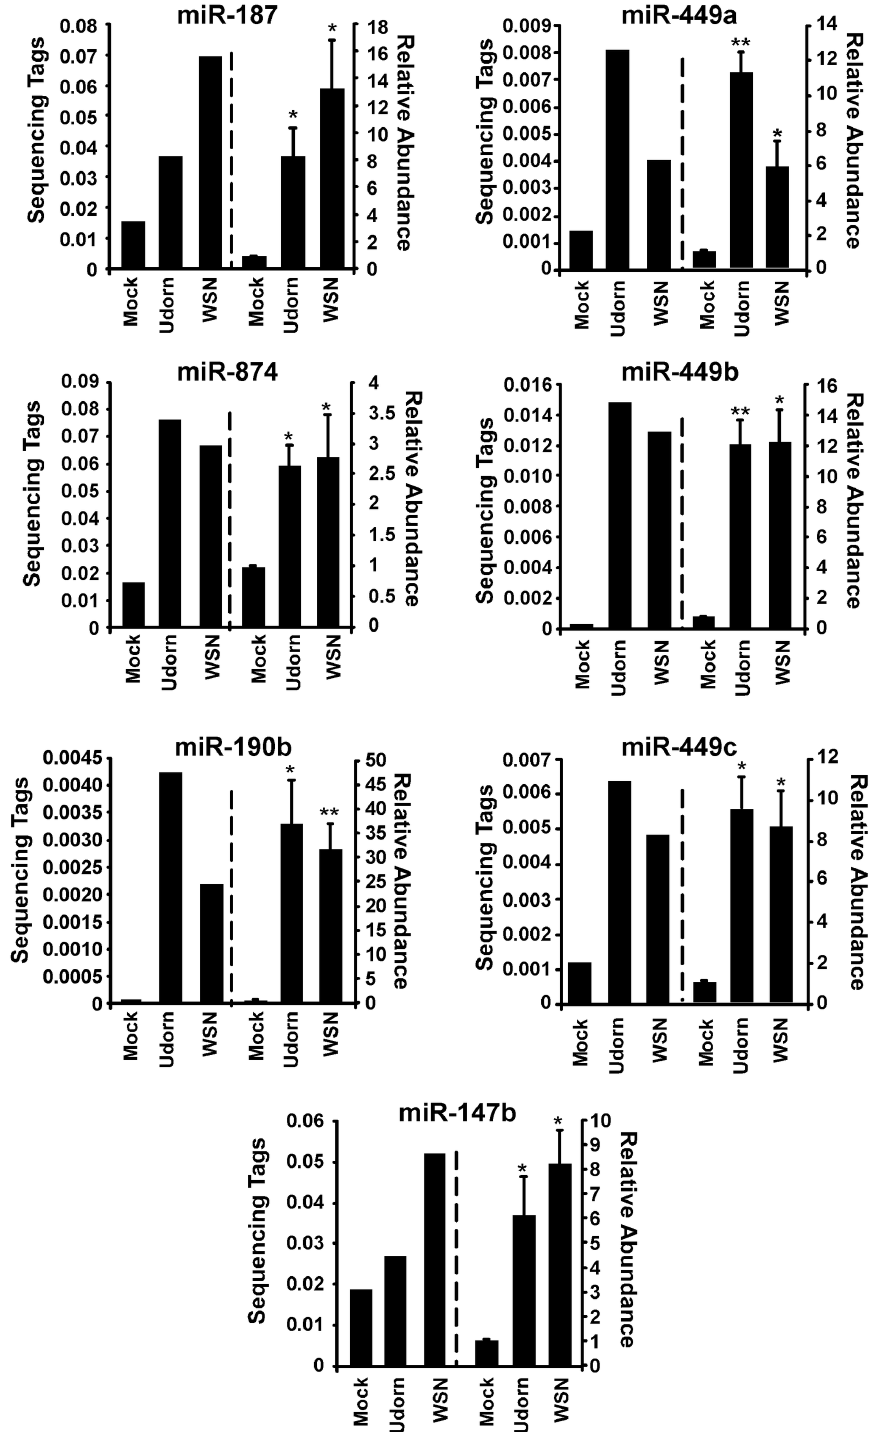
Figure 2. Validation of microRNA activation by influenza A virus infection. A549 cells were mock infected or infected with either A/Udorn/72 or A/WSN/33 (5 pfu/cell). RNA was purified 10 hours post infection and used construct a library for small RNA deep sequencing or TaqMan miRNA RT-qPCR. Data to the left of the dotted vertical line indicate the normalized sequence tags for the indicated miRNA. Data to the right of the dotted vertical line indicate RT-qPCR analysis of the indicated miRNA. Statistical analysis was performed by a two-tailed t-test (p-value<0.05=*, p-value<0.01=**). doi: 10.1371/journal.pone.0076560.g002 PLOS ONE |